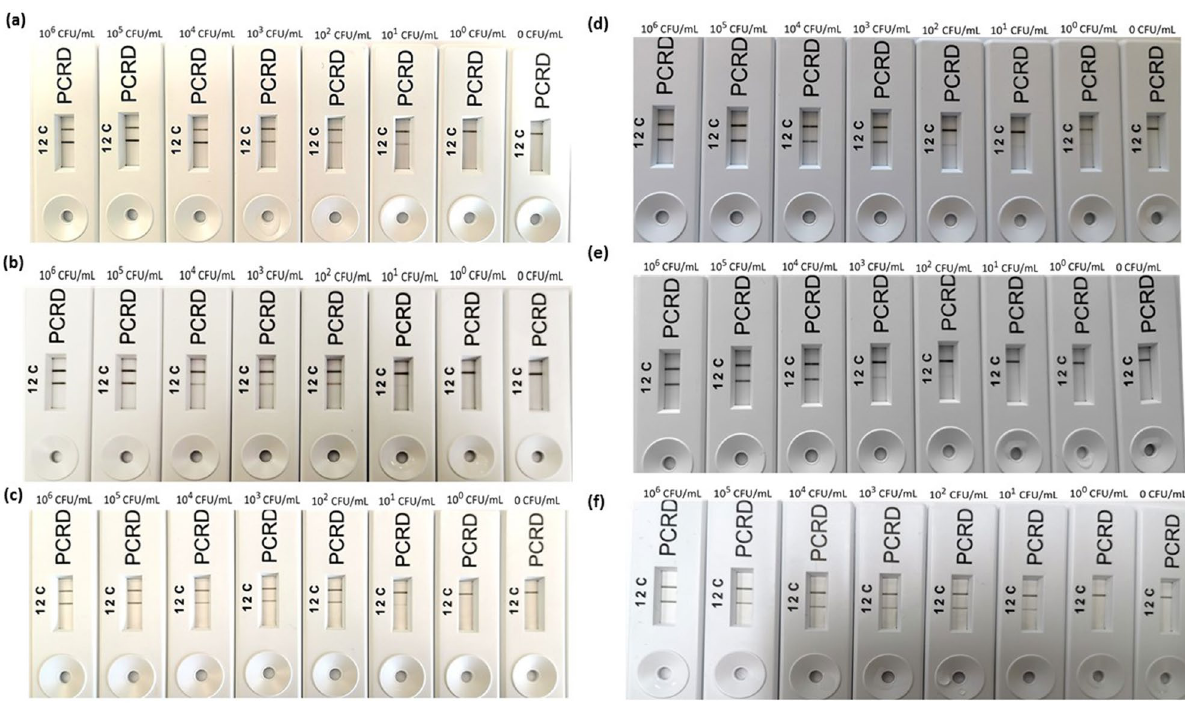
Figure 6. Typical images of the RPA-LFA ( a – c ) using rfbE F1/R1 primer set (targeting rfbE gene) and ( d – f ) stx2 F1/R1 (targeting stx gene) for the spiked commercial samples. From left to right, the concentrations of E. coli O157:H7 are 10 6 CFU/mL, 10 5 CFU/mL, 10 4 CFU/mL, 10 3 CFU/mL, 10 2 CFU/mL, 10 1 CFU/mL, 10 0 CFU/ mL and 0 CFU/mL. ( a , d ) For drinking water samples, ( b , e ) for milk sample, ( c , f ) for apple juice